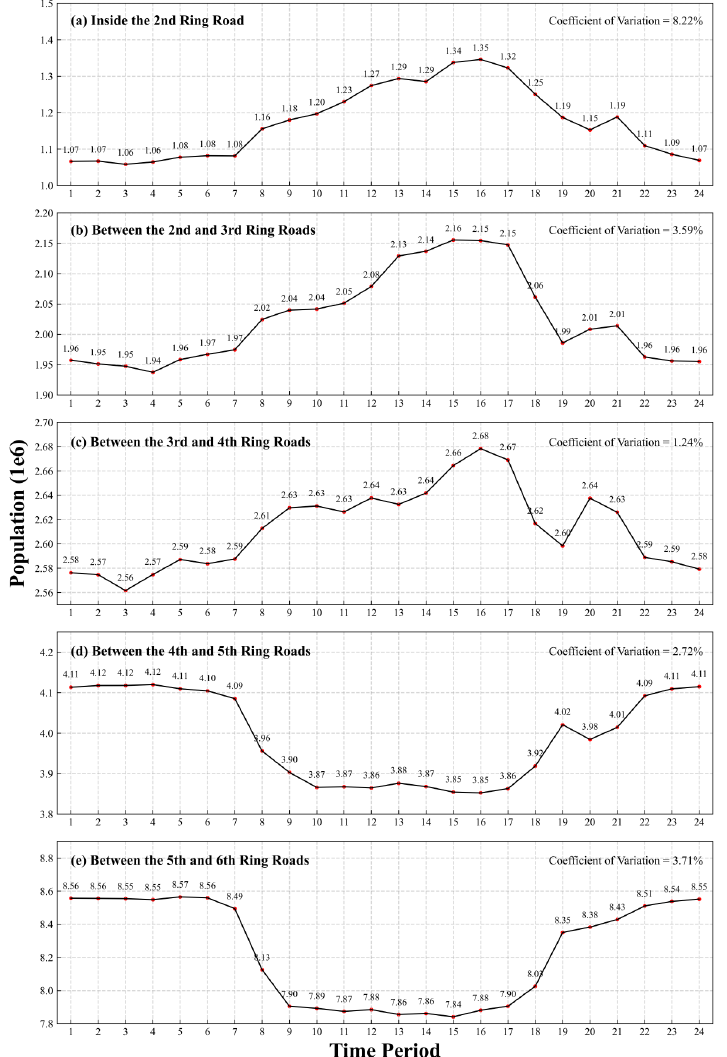
Figure 7. Spatiotemporal variation in population between ring roads in Beijing during a regular weekday. The numbers in the horizontal coordinates represent each of the 24 time periods of the day (i.e., 0:00–1:00, 1:00–2:00, 2:00–3:00, 3:00–4:00,